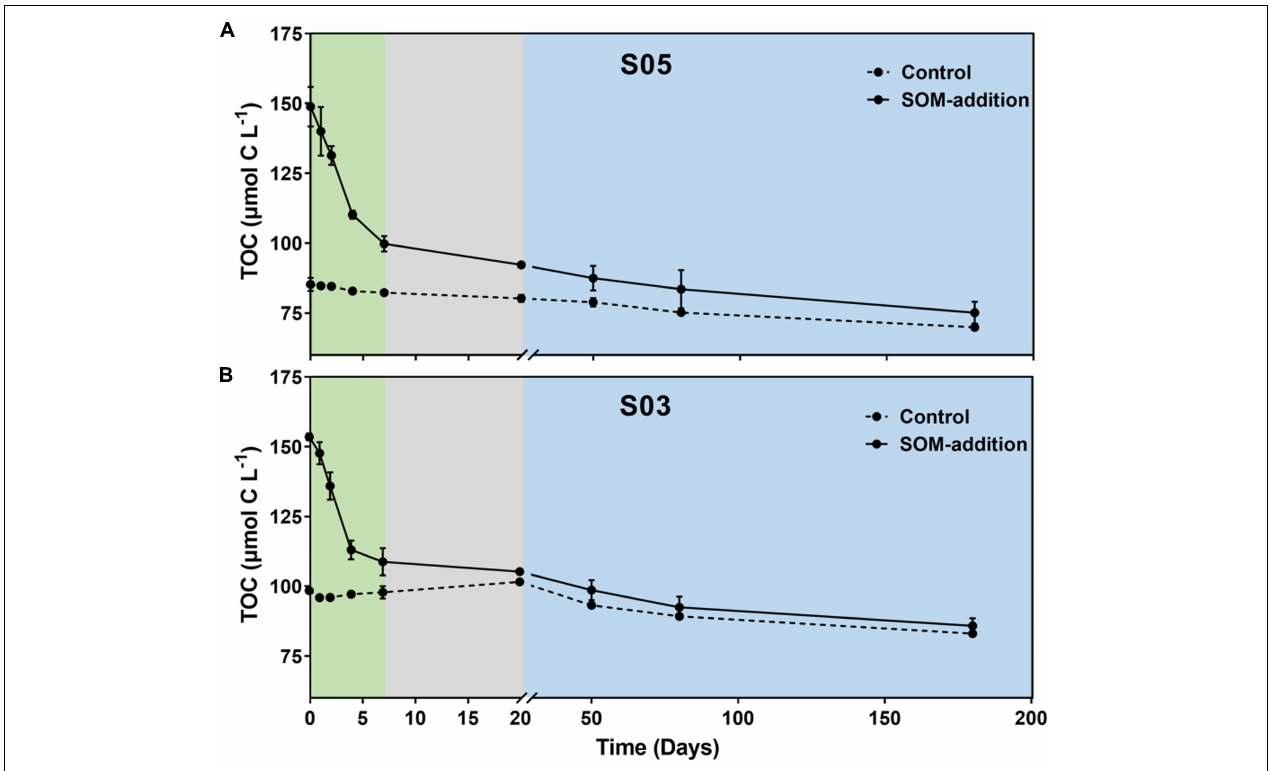
FIGURE 2 | Variation in TOC concentrations throughout incubations at stations (A) S05 and (B) S03. Three phases (I, II, and III) were identified based on the rate of TOC consumption in the SOM-addition groups. Phase I: from 0 to 7 days, indicated by the green shading; Phase II: from 8 to 20 days, indicated by the gray shading; and Phase III: from 21 to 180 days, indicated by the blue shading. Error bars represent the range of values from triplicate measurements for SOM-addition groups and duplicate measurements for the control